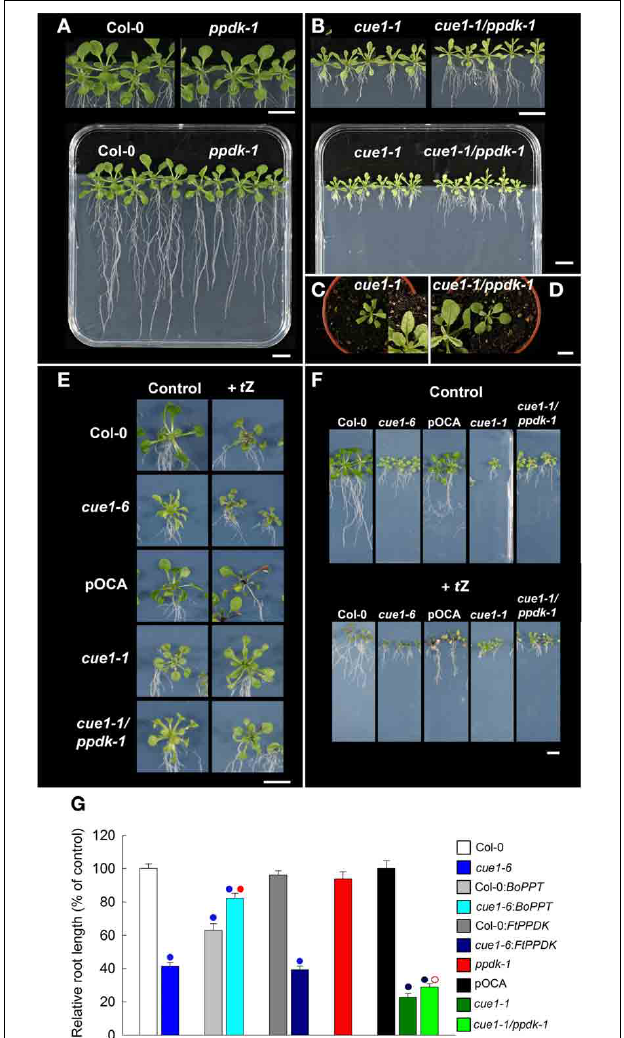
FIGURE 10 | Effect of t Z feeding on the root and leaf phenotypes of cue1 and ppdk1-1 single mutants as well as cue1-1/ppdk double mutants. Plants were grown for three weeks vertically on ½MS agar plates or for four weeks on soil (C,D) . Root and shoot phenotypes of Col-0 and ppdk-1 (A) as well as cue1-1 and cue1-1/ppdk-1 double mutants (B) . Col-0, cue1-6 , pOCA, cue1-1 , and the cue1-1/ppdk-1 double mutant fed with 1 μ M t Z were compared to an unfed control and the leaf (E) and root (F) phenotypes were analyzed. The data on relative root lengths in (G) represent the mean ± SE of n = 10–24 replicates. The analyses of root lengths also contain BoPPT and FtPPDK overexpressing wild-type and cue1-6 mutant plants. Blue circles indicate significant differences in root length referred to Col-0 ( P < 0 . 01), whereas red circles reflect significant changes in root lengths of BoPPT overexpressors in the cue1-6 background compared to the untransformed mutant or of cue1-1/ppdk1-1 double mutant compared to the cue1-1 single mutant. Closed or open red circles indicate P < 0 . 01 or P < 0 . 05, respectively. The scale bars in the individual sub-figures indicate a distance of